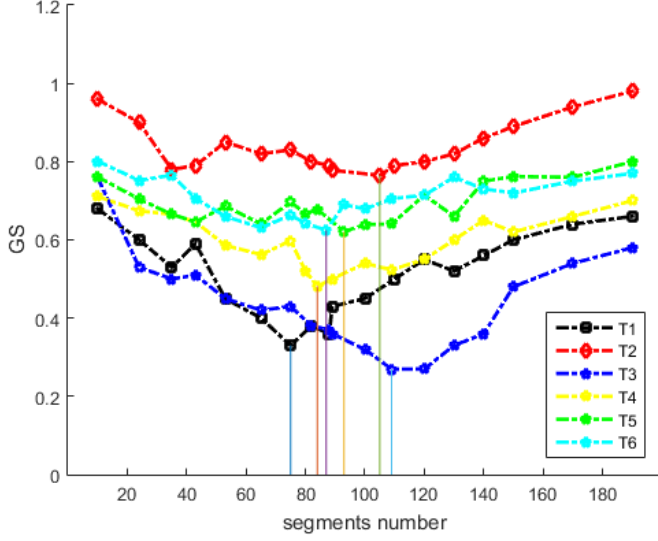
Figure 19. The indicator diagram of the segmentation accuracy GS and the different segment numbers on the three test images: Albany QuickBird image (T1); Manhattan aerial image (T2); Montgomery aerial image (T3); Potsdam aerial image (T4); Potsdam aerial image (T5); Potsdam aerial image (T6).